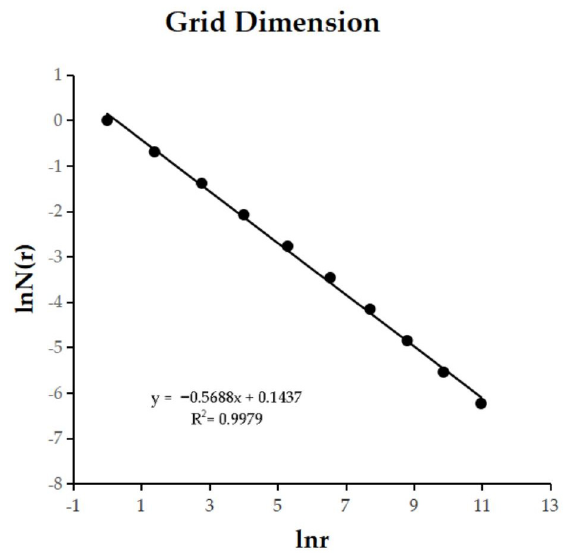
Figure 4. Grid dimension double logarithm diagram of green space in Block 15.